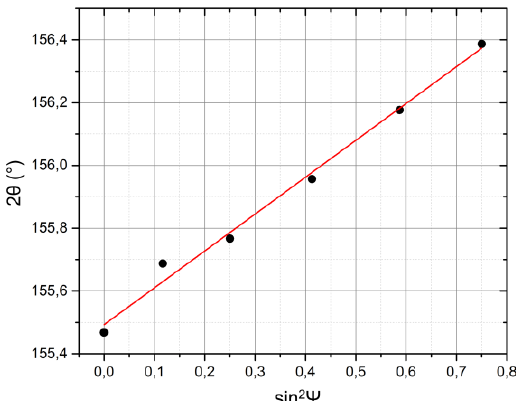
Figure 1. Linear approximation of the 2θ (211) dependence on sin 2 ψ for the Fe film.